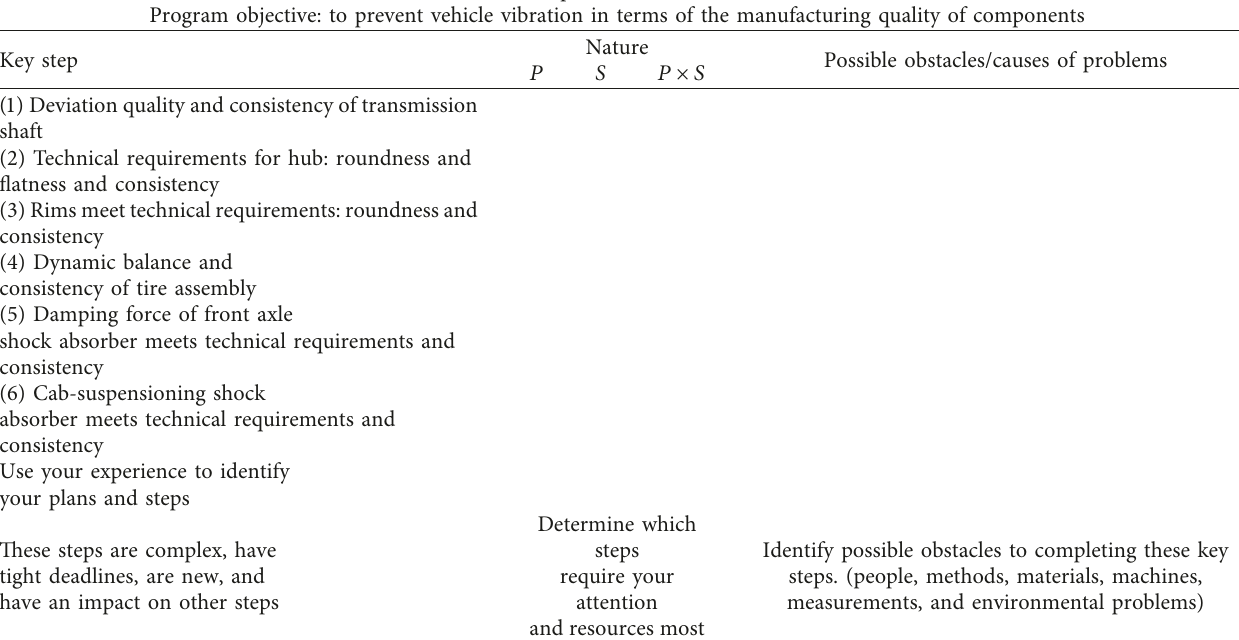
Table 9: Problem prevention worksheet. Problem prevention